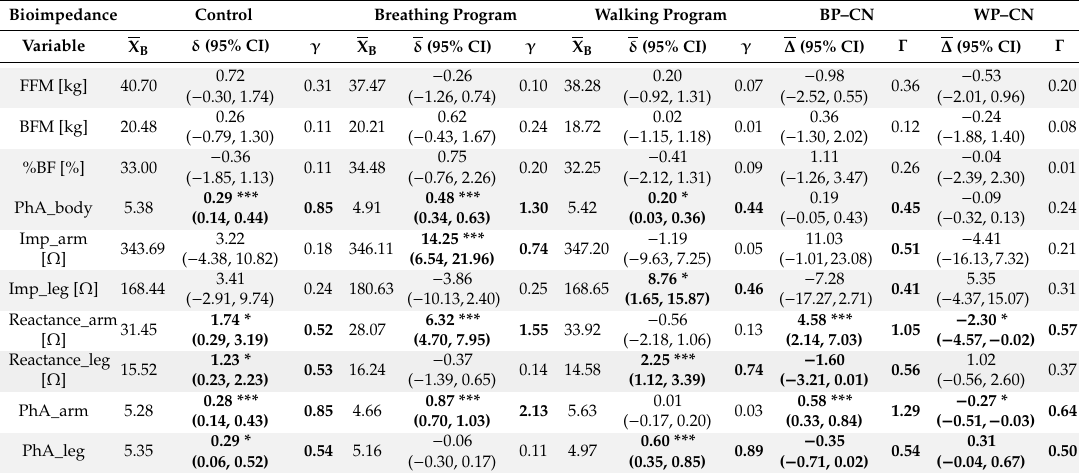
Table 4. Changes in the bioimpedance variables after the FTPs (analysis of covariance (ANCOVA) results). The details are identical to those in Table 3. FFM, fat-free mass; BFM, body fat mass; %BF, % body